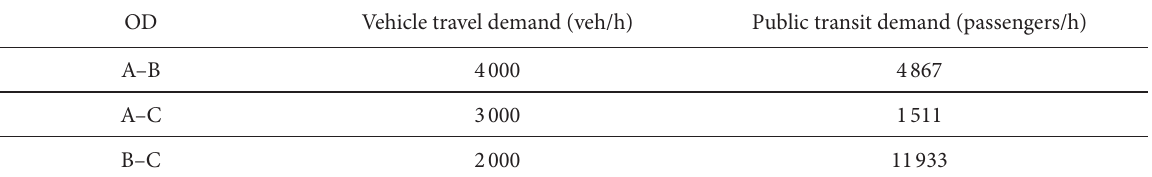
Table 3. Travel demand